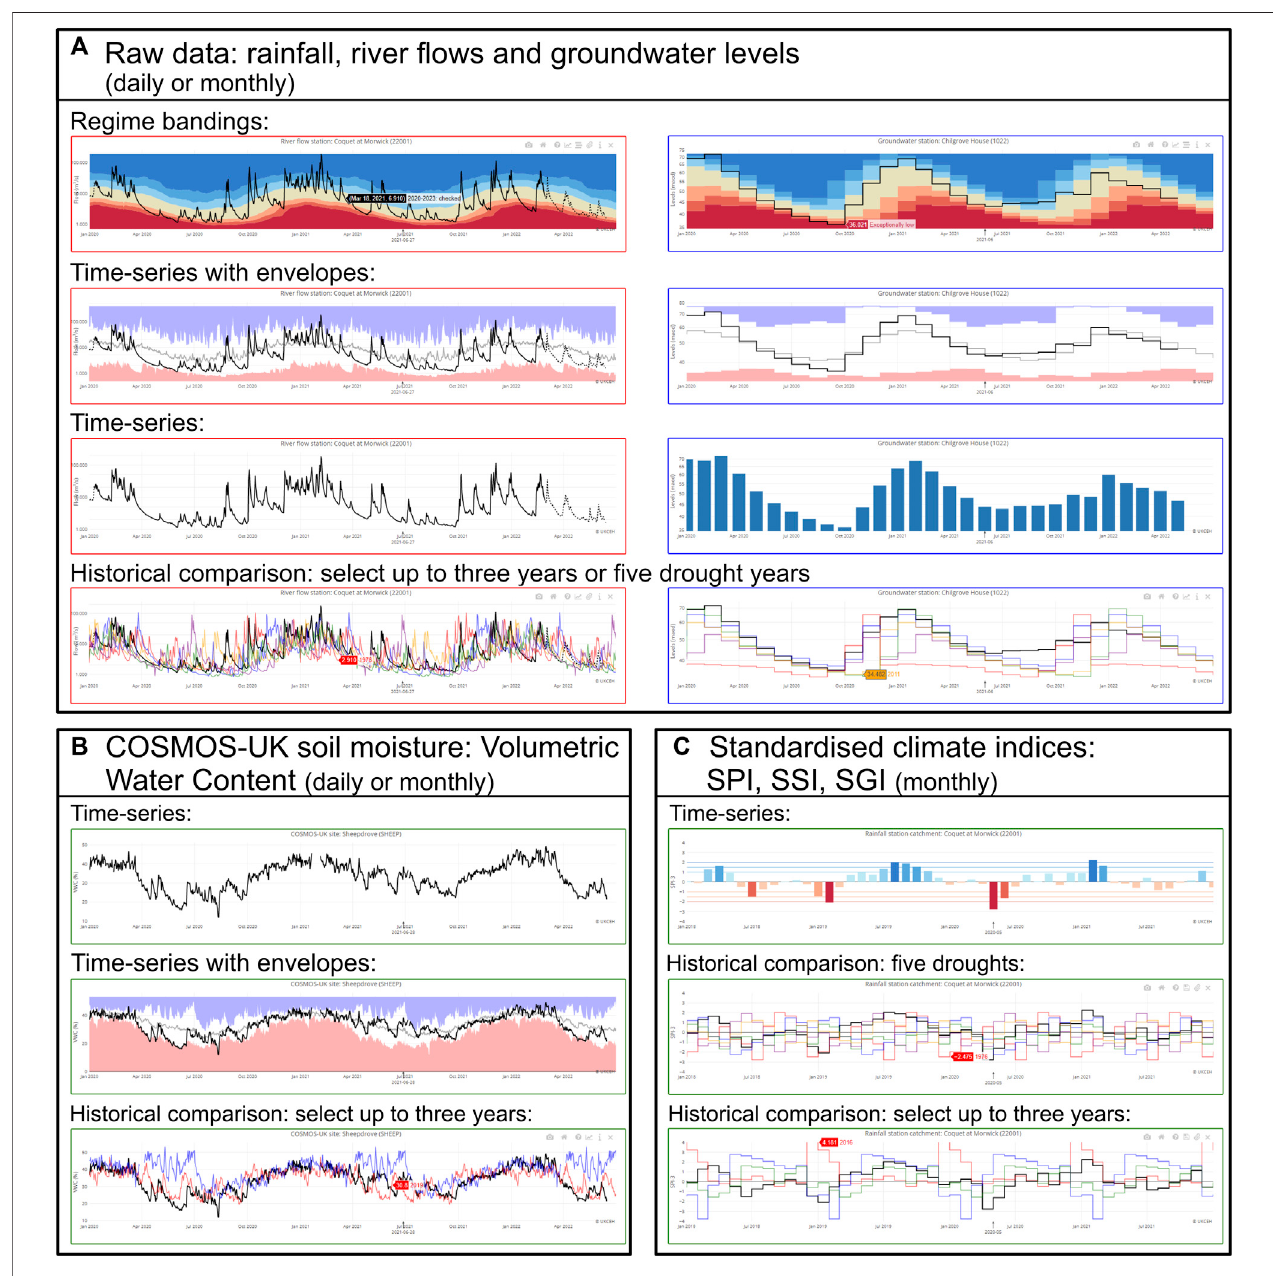
FIGURE 4 | Examples of plot types in the UK Water Resources Portal showing (A) daily river fl ow data for the River Coquet at Morwick and monthly groundwater levels at Chilgrove House, (B) soil moisture data for the COSMOS-UK site at Sheepdrove, and (C) SPI-3 for the Coquet catchment.